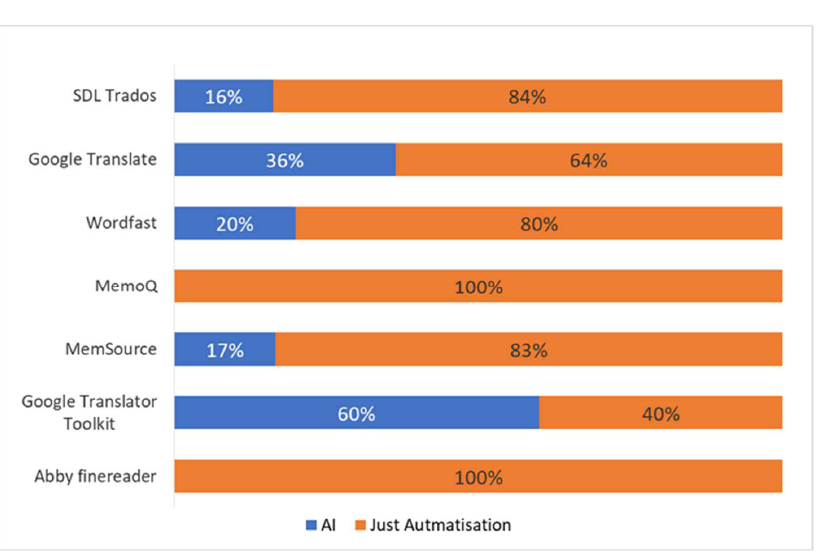
Figure 7. Do you think the following programmes are AI or just automatization tools? N =